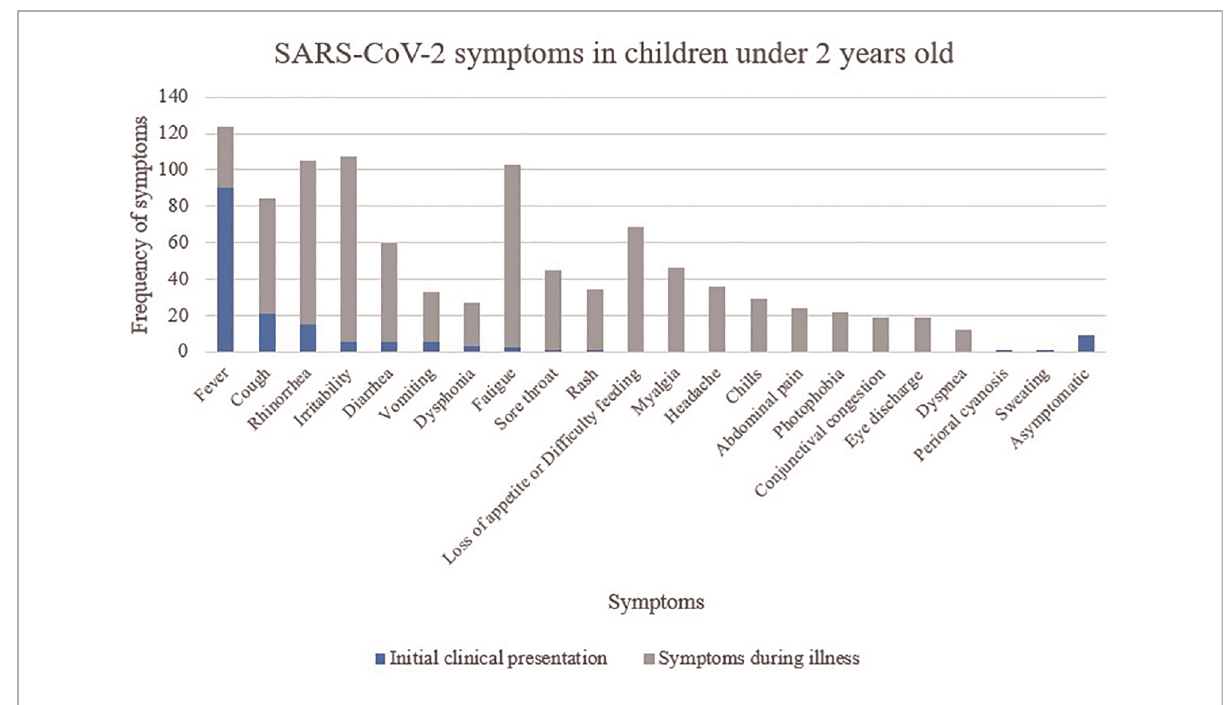
FIGURE 2 Clinical features at initial presentation and during illness in 159 children with